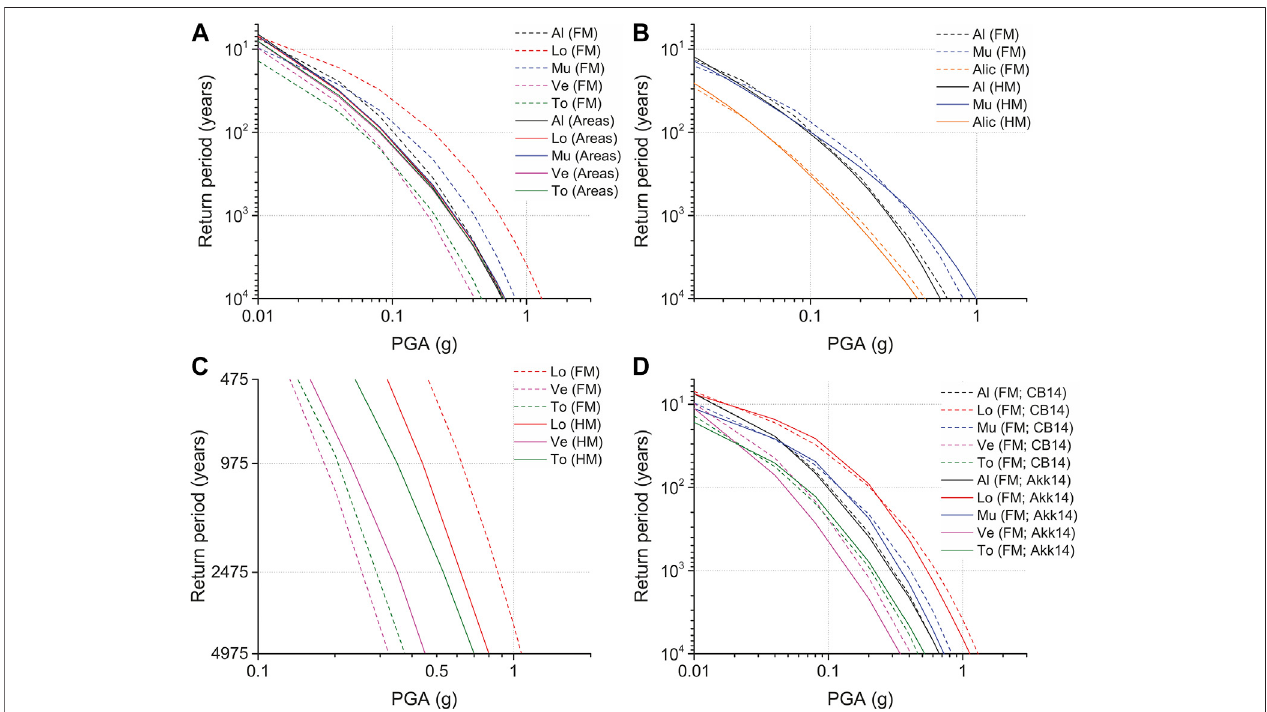
FIGURE 10 | (A) Mean hazard curves for PGA (g) of the FM model plotted with the ones of the ZESIS areas model for the cities of Almería (Al), Lorca (Lo), Murcia (Mu),Vera(Ve)andTorrevieja(To); (B) MeanhazardcurvesforPGA(g)oftheFMmodelandtheHMmodelfromRivas-Medinaetal.,2018forthecitiesofAlmería,Alicante (Alic) and Murcia and (C) for the cities ofLorca, Vera and Torrevieja. In these last three cities, the results are visually inferred from pixels ofthe maps from this publication, hence the curves are exclusively plotted for the return periods of 475, 975, 2,475, and 4,975 years (D) Mean hazard curves for PGA (g) of the FM model using the CB14 (Campbell and Bozorgnia, 2014) and Akk14 (Akkar et al., 2014) GMPEs and for the same cities as Figures 6 , 10A .